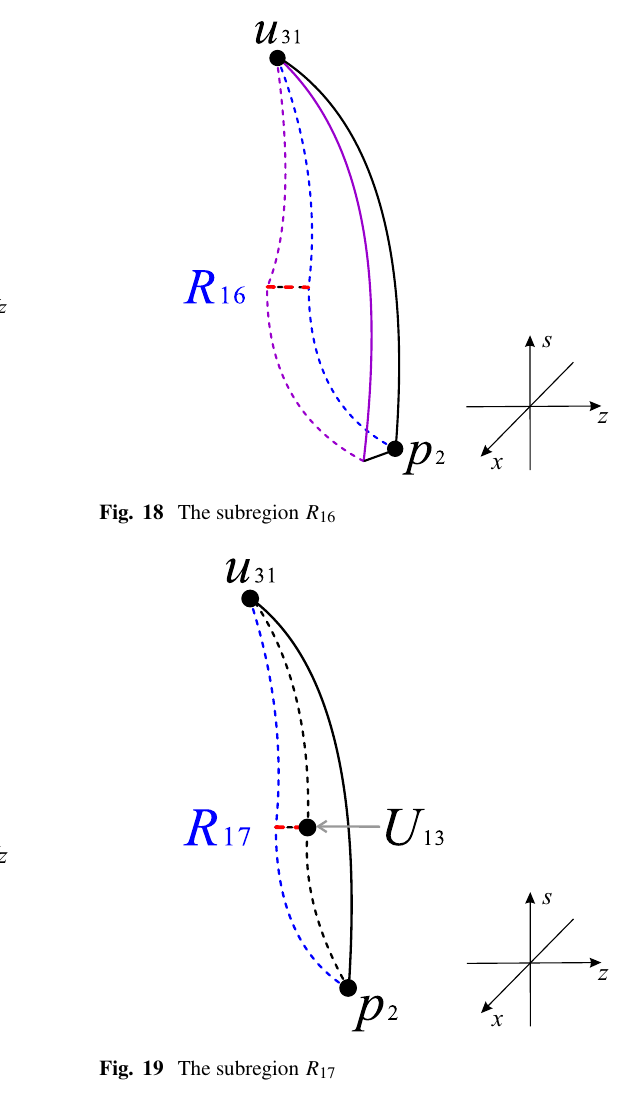
Fig. 19 The subregion R